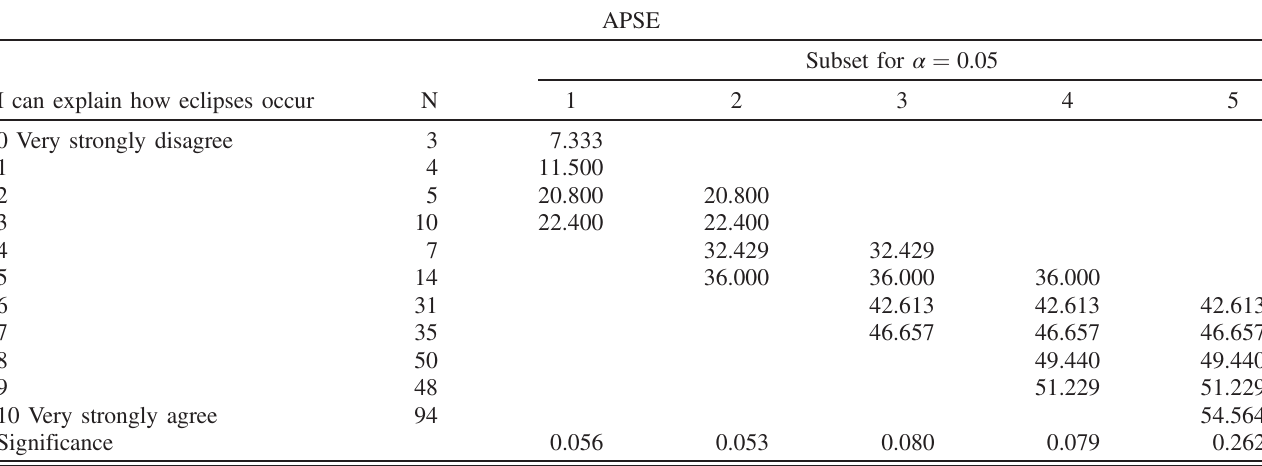
TABLE V. Multiple comparisons using SNK for homogeneous subgroups of APSE based on the item indicated. Note that means for groups in homogeneous subsets are